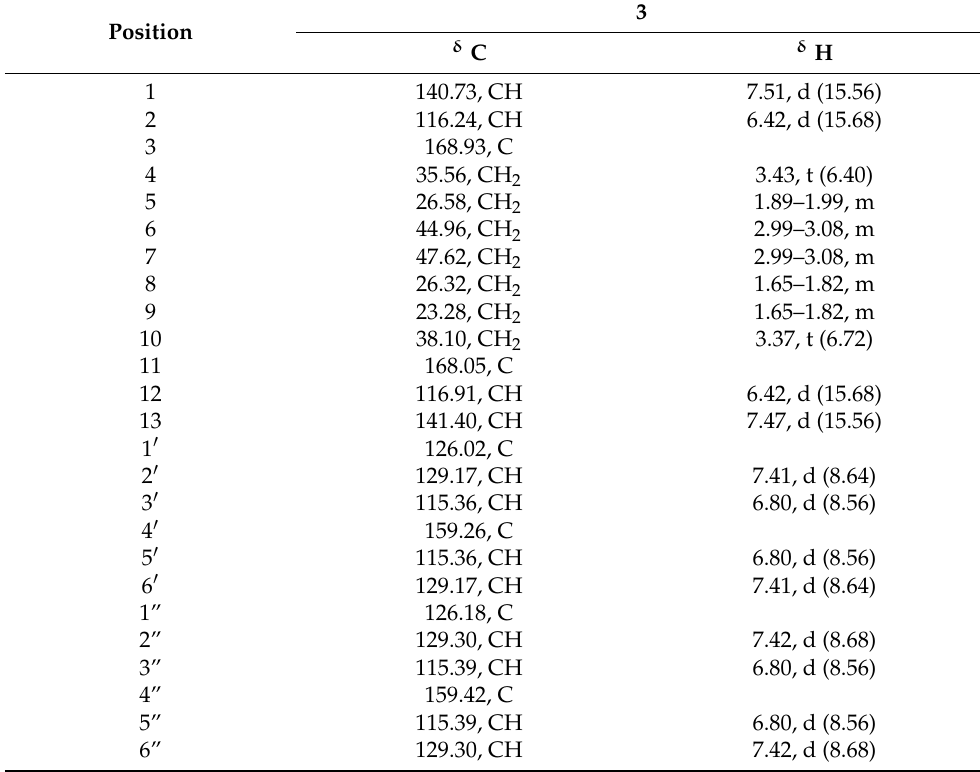
Table 2. 13 C and 1 H-NMR data for compound 3 (at 400 MHz for 1 H-NMR and 100 MHz for 13 C-NMR in CD 3 OD, δ in ppm, J in